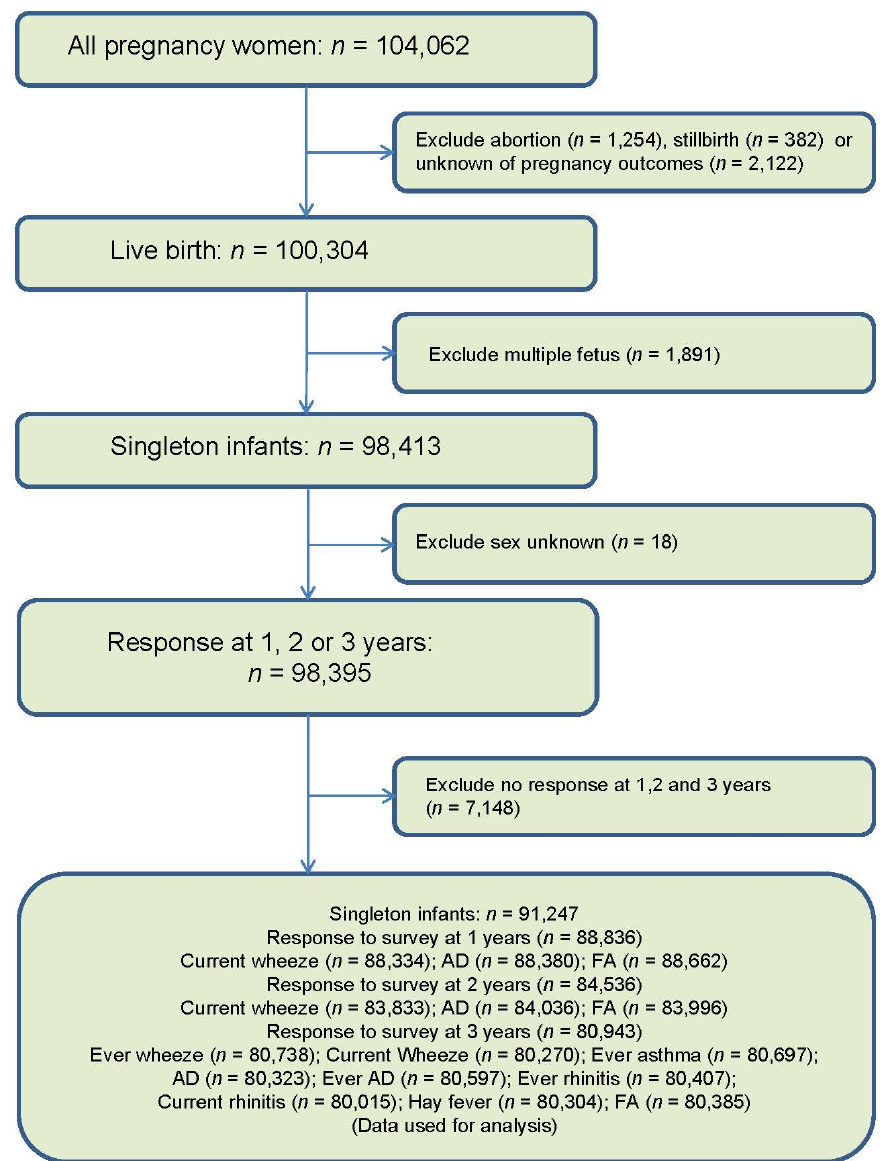
Figure 1. Flow chart of data selection.